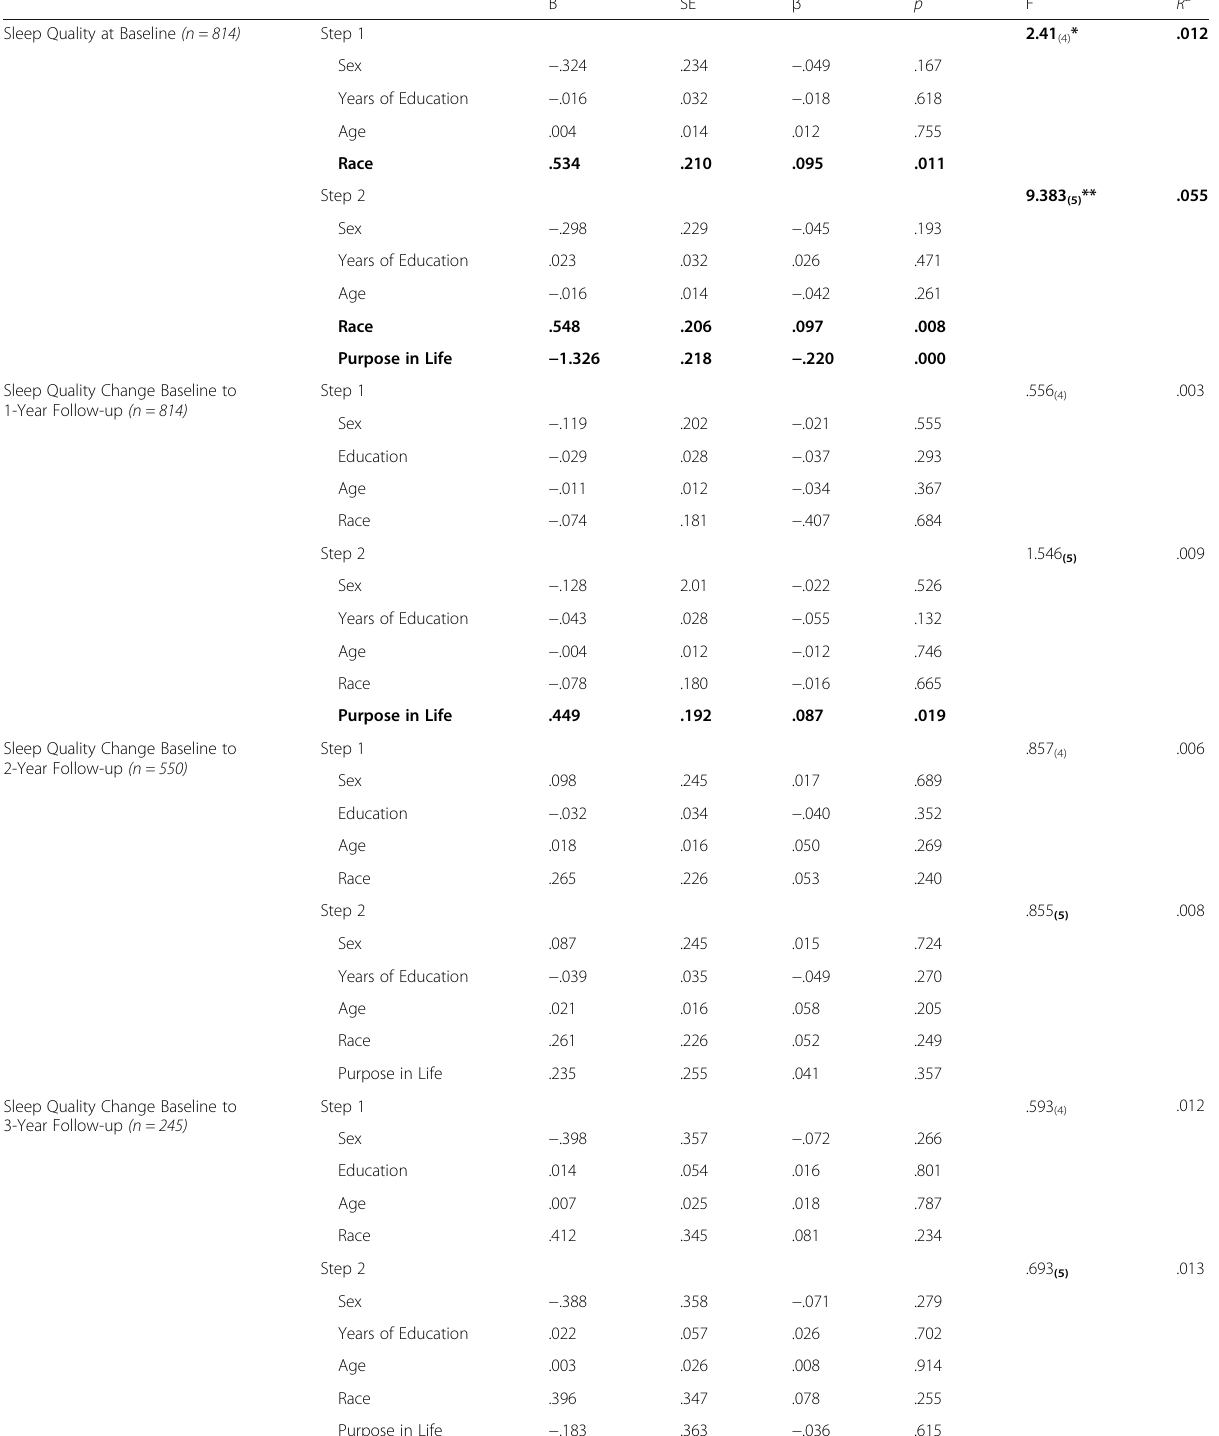
Table 2 Hierarchical Multiple Linear Regression Analyses of Purpose in Life and Sleep Quality B SE β p F R 2 Sleep Quality at Baseline